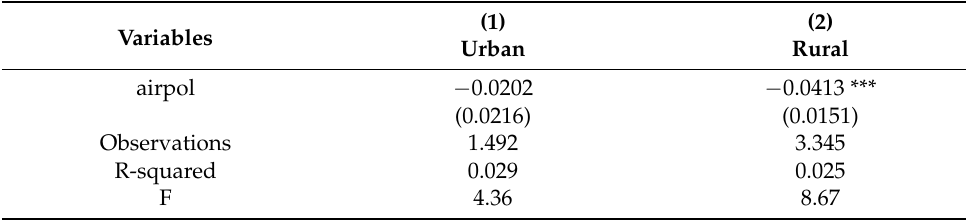
Table 5. Discussion on urban/rural heterogeneity. (1) (2) Variables Urban Rural airpol − 0.0202 − 0.0413